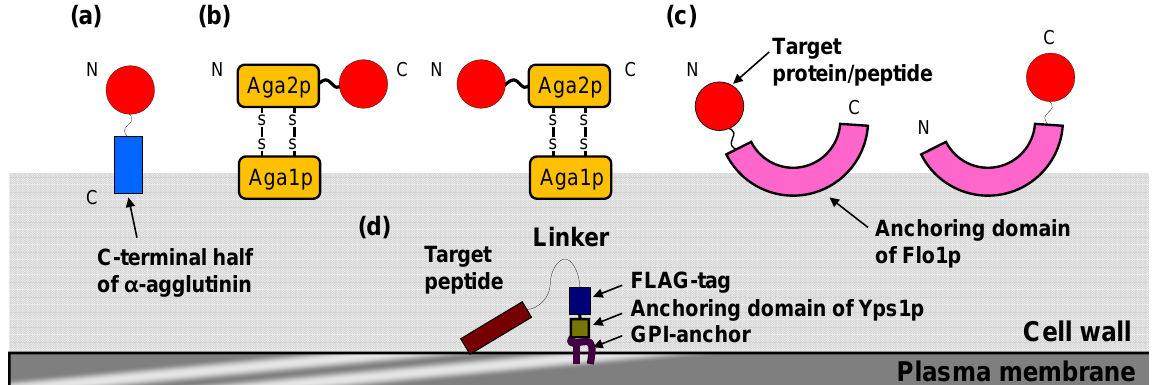
Figure 1. Cell surface display system in S. cerevisiae ( a ) α-agglutinin-based display system; ( b ) a -agglutinin-based display system; ( c ) Flo1p-based display system; ( d ) Membrane display system by anchoring domain of